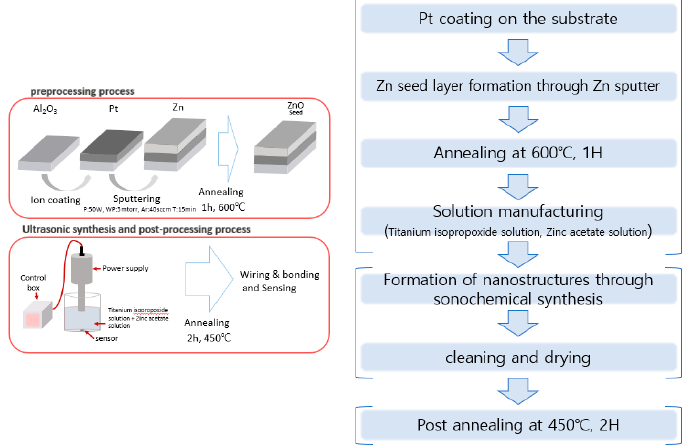
Table 1. ZnO-TiO 2 gas sensor conditions.